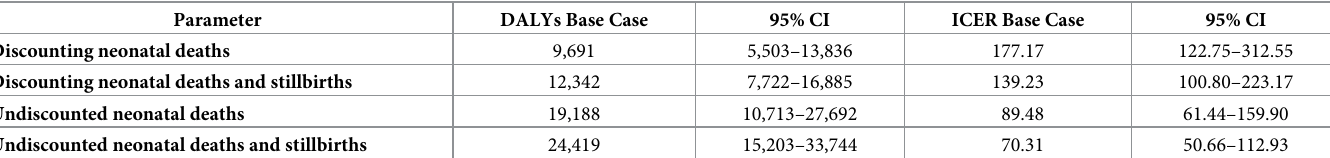
Table 7. Sensitivity analysis using steady-state rate.